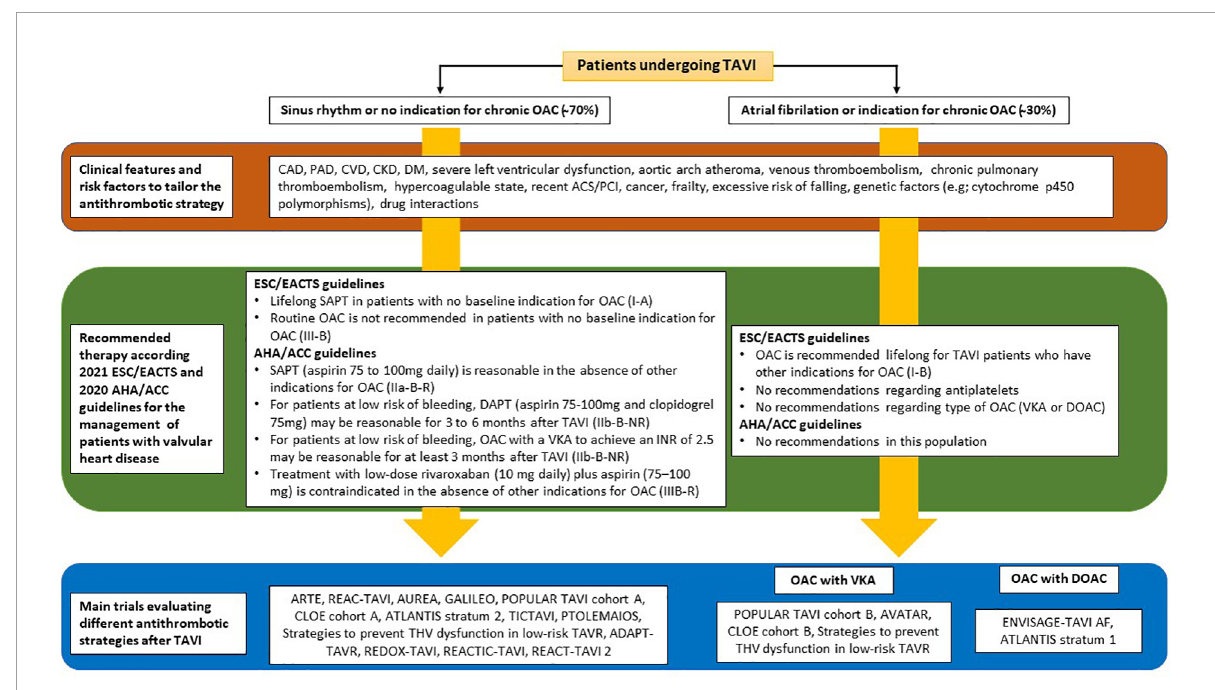
FIGURE3 Summary of current recommendations of the European and American guidelines on the antithrombotic regimen after TAVI, including the main studies assessing a variety of antiplatelet and anticoagulant combinations. TAVI, transcatheter aortic valve implantation; OAC, oral anticoagulation; CAD, coronary artery disease; PAD, peripheral artery disease; CVD, cerebrovascular disease; CKD, chronic kidney disease; DM, diabetes mellitus; ACS, acute coronary syndrome; PCI, percutaneous coronary intervention; ESC, European Society of Cardiology; EACTS, European Association for Cardio-Thoracic Surgery; AHA, American Heart Association; ACC, American College of Cardiology; ASA, acetylsalicylic acid; DAPT, dual antiplatelet therapy; SAPT, single antiplatelet therapy; HBR, high-bleeding risk; VKA, vitamin K antagonist; LBR, low bleeding risk; DOAC, direct oral